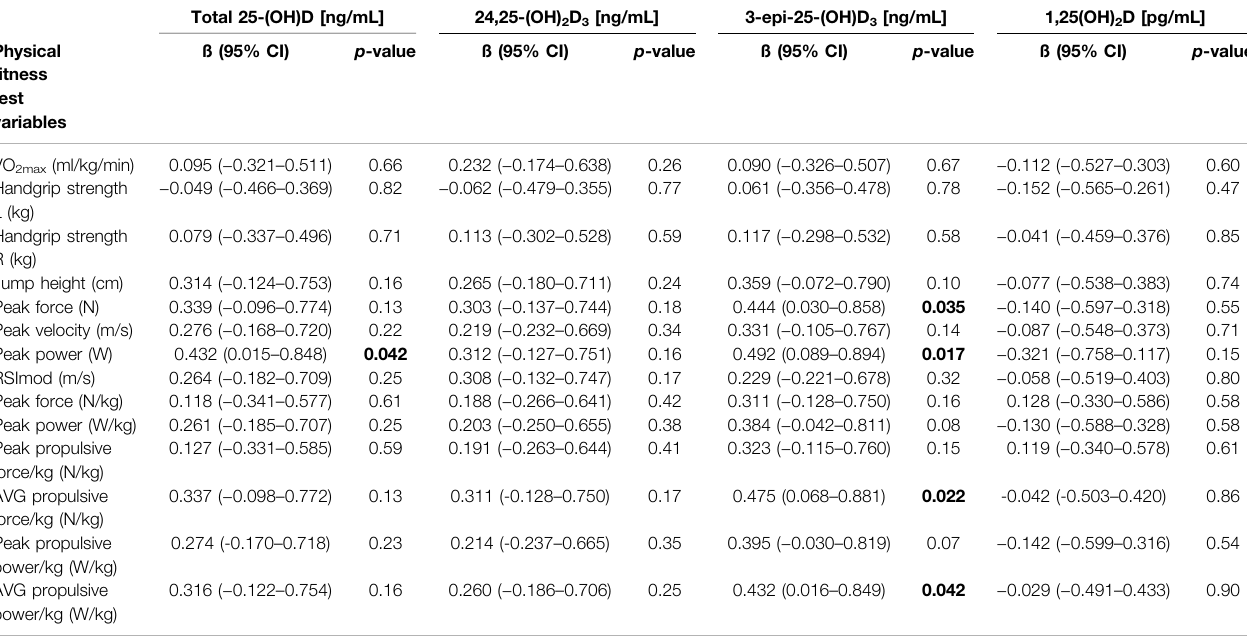
TABLE 3 | Association of athletic performance with vitamin D metabolites by multiple regression analyses* in outdoor players ( n =